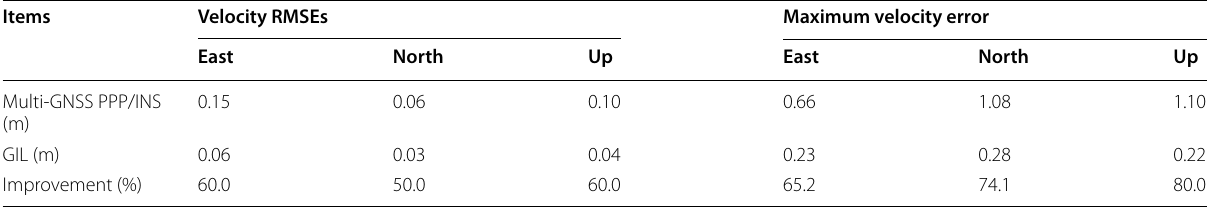
Table 5 RMSEs and maximum error of velocity for multi-GNSS PPP/INS and GIL solutions in GNSS partly-blocked experiment